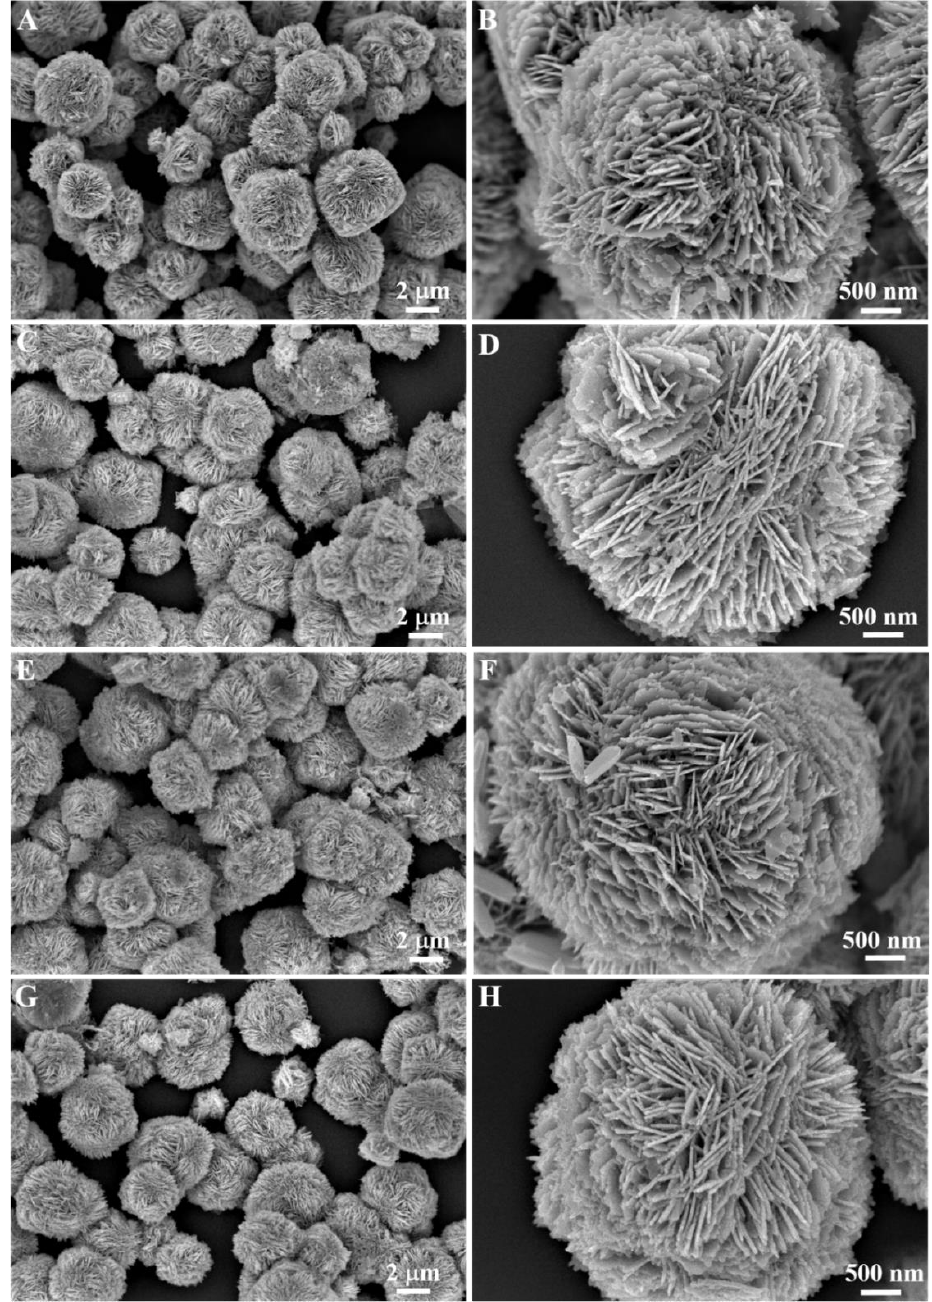
Figure 1. SEM images of ZnO nanoflowers ( A , B ), Ag-1/ZnO ( C , D ), Ag-3/ZnO ( E , F ), and Ag-5/ZnO ( G , H ).